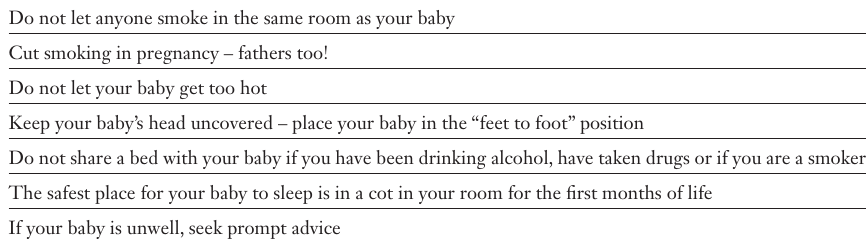
Recommendations for preventing the risks for